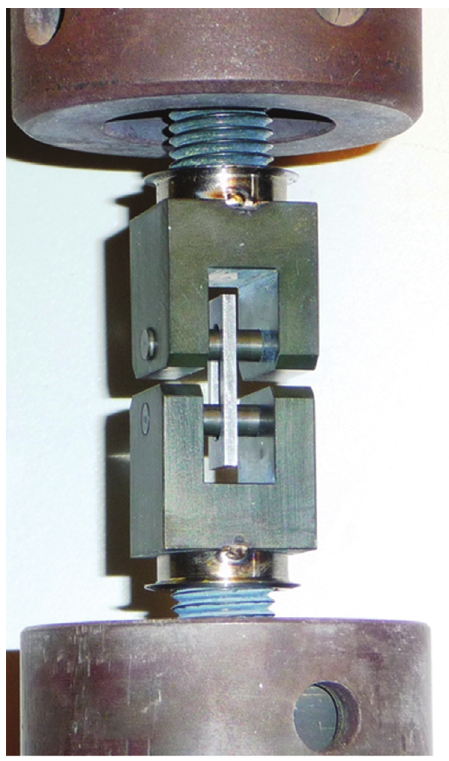
Figure 15: Photograph of the TBS loading setup, illustrates the loading method and the difference in the stiffness between the specimen and the loading fixtures.